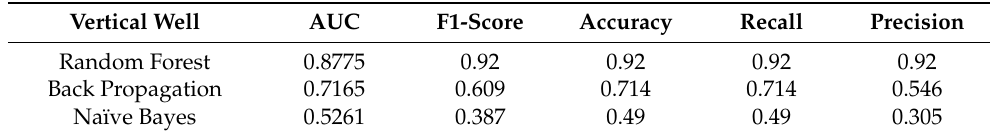
Table 1. Comparison of accuracy of three methods with horizontal well data. Vertical Well